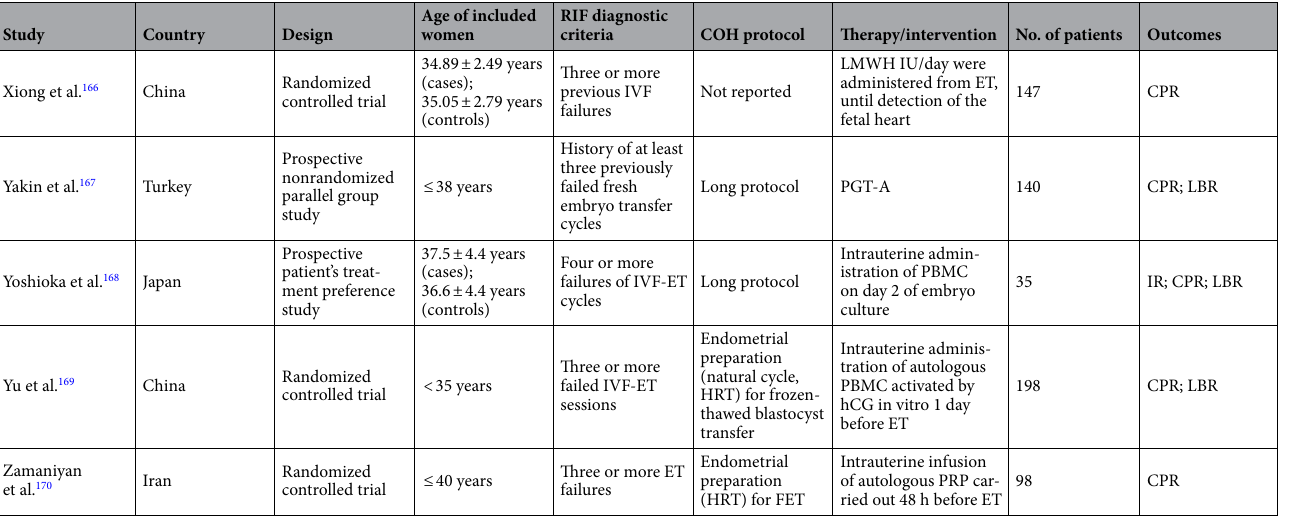
Table 2. Characteristics of the included studies. IVF in vitro fertilization, RIF repeated implantation failure, COH controlled ovarian hyper stimulation, ICSI intracytoplasmic sperm injection, ET embryo transfer, HRT hormone replacement therapy, FET frozen embryo transfer, G-CSF granulocyte-colony stimulating factor, LMWH low molecular weight heparin, PBMC peripheral blood mononuclear cells, AH assisted hatching, PGT- A preimplantation genetic testing for aneuploidy, IVIG intravenous immunoglobulin, PRP platelet rich plasma, hCG human chorionic gonadotropin, ZIFT zygote intrafallopian transfer, IR implantation rate, CPR clinical pregnancy rate, MR miscarriage rate, MPR multiple pregnancy rate, LBR live birth